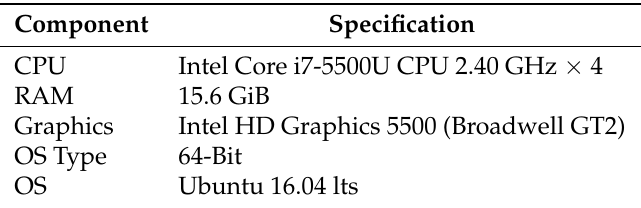
Table 4. Simulation computer relevant